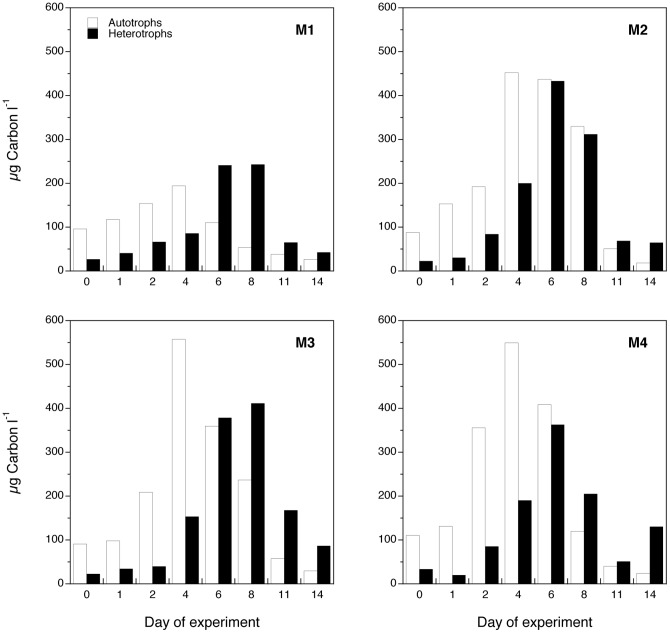
Autotrophic and micro-heterotrophic biomass (μg C l-1) in the four mesocosm treatments along the experiment.Values are averages of the two replicates (A, B) for each treatment and error bars correspond to the SD. See methods section for explanation on the biomass calculations.